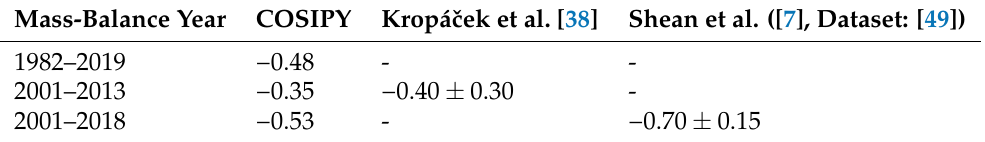
Table 6. Comparison of simulated annual glacier-wide climatic mass balance B clim , a (mw.e.a −1 ) with other studies using digital elevation model differences at the Halji